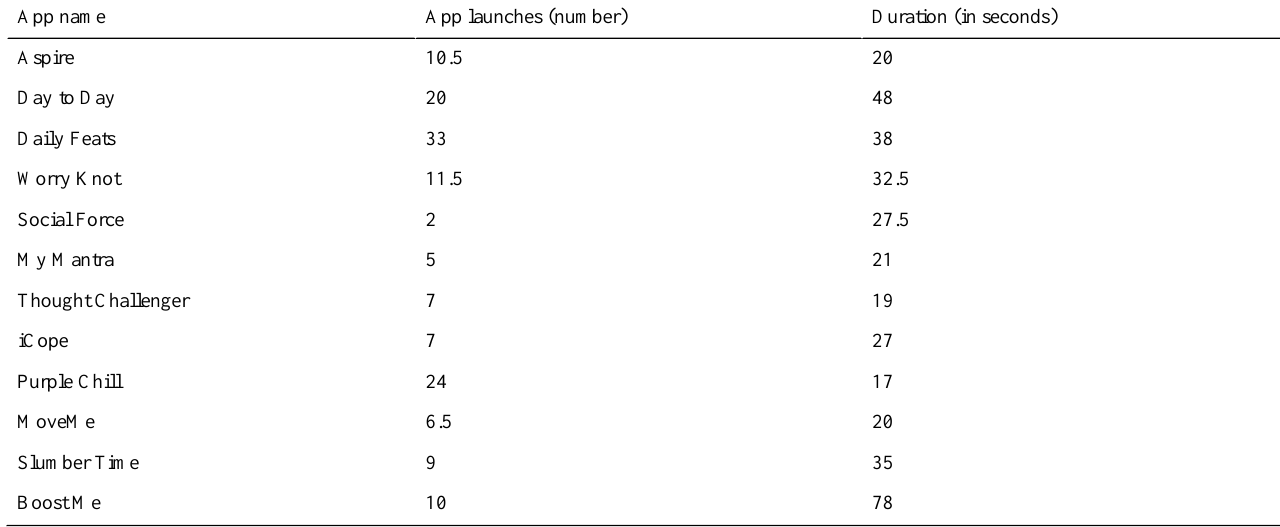
Table 3. Median number of app launches and median duration of app launches of individual IntelliCare